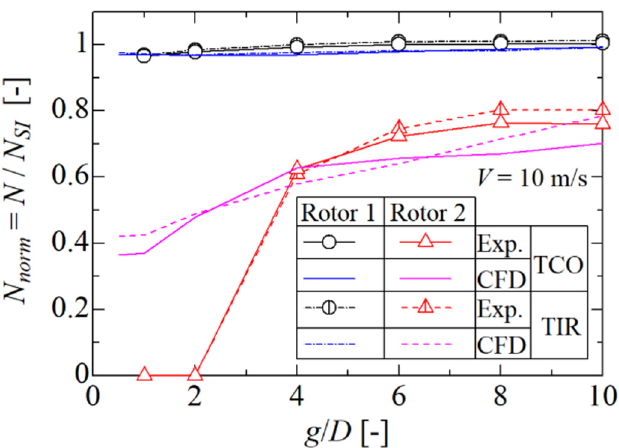
Figure 12. Comparison between the wind-tunnel experiment and CFD (reproduced with permission from Hara et al. [13]) on VAWTs in tandem layouts at V = 10 m/s.